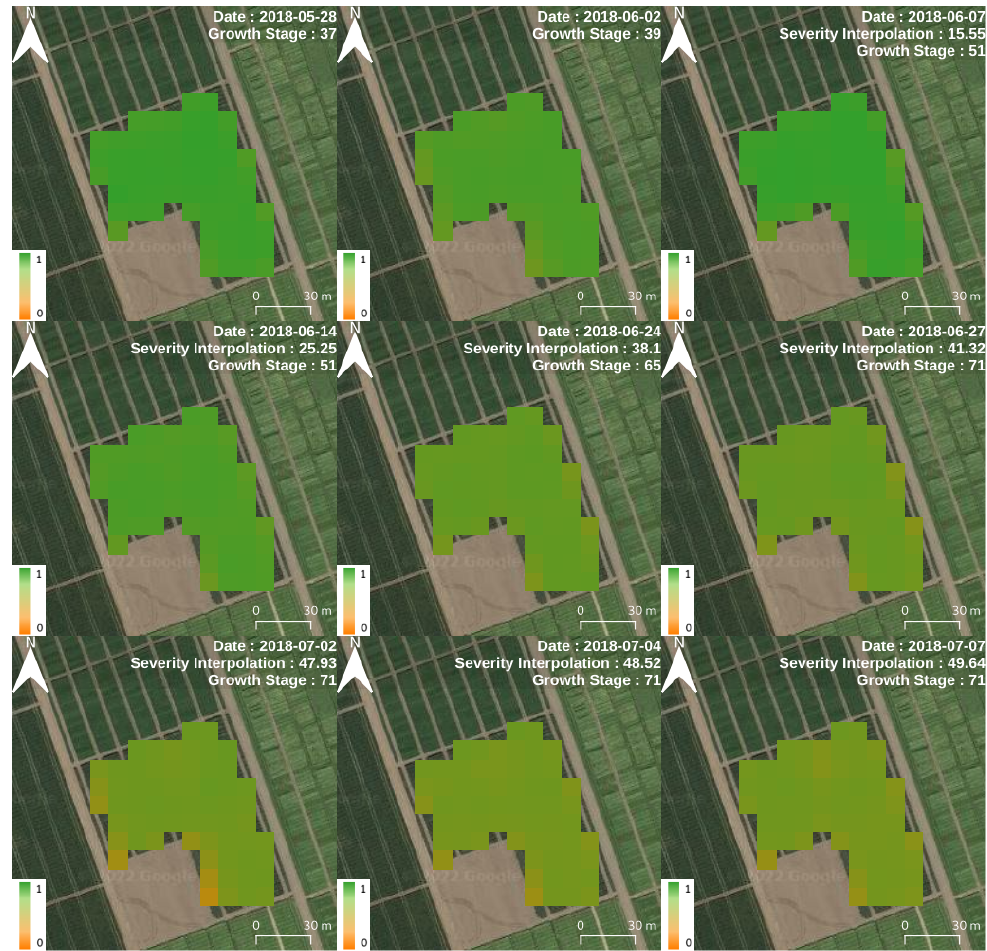
Figure 1. Time series plot of NDVI maps from a trial location in UK during 2018 with reported observations of increasing yellow rust disease